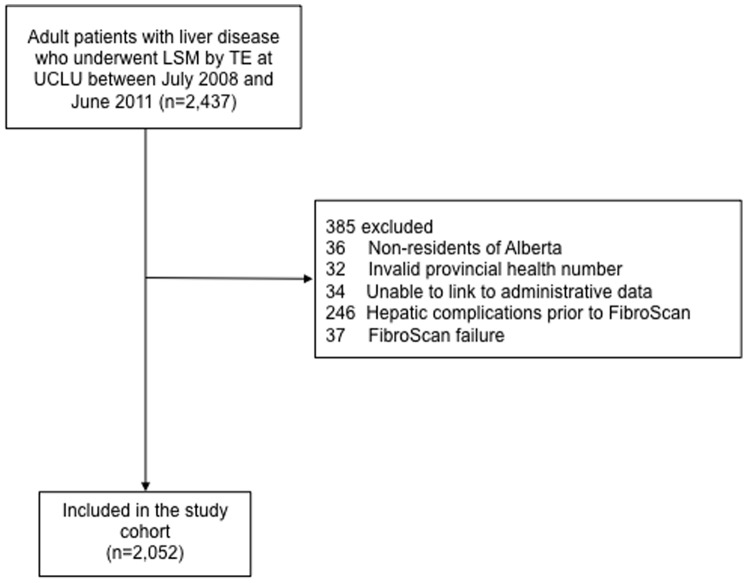
Flow diagram of study participants.